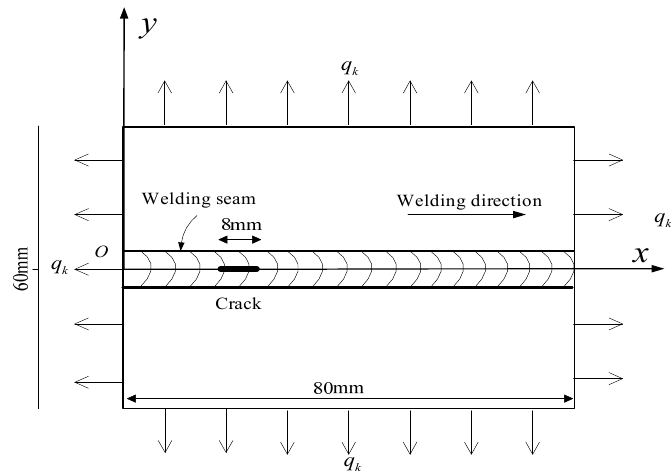
Figure 15. Geometry and boundary conditions of the welding cooling process with an inclined isothermal crack.